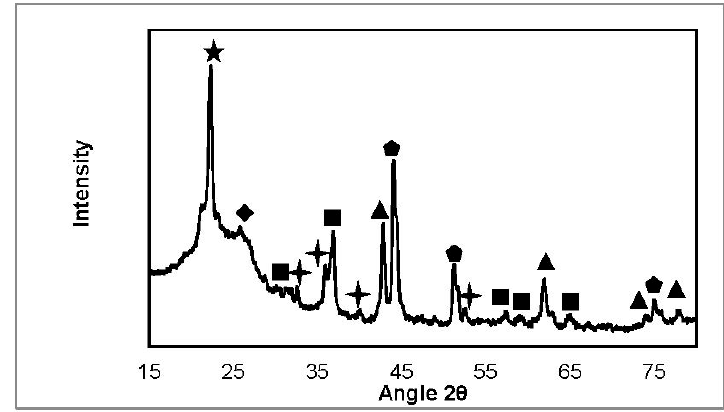
Figure 14. XRD spectra of Ni-UGSO after bio-oil MemU SR at 800 °C, WHSV = 2.0 g/g cat /h and TOS = 105 h.